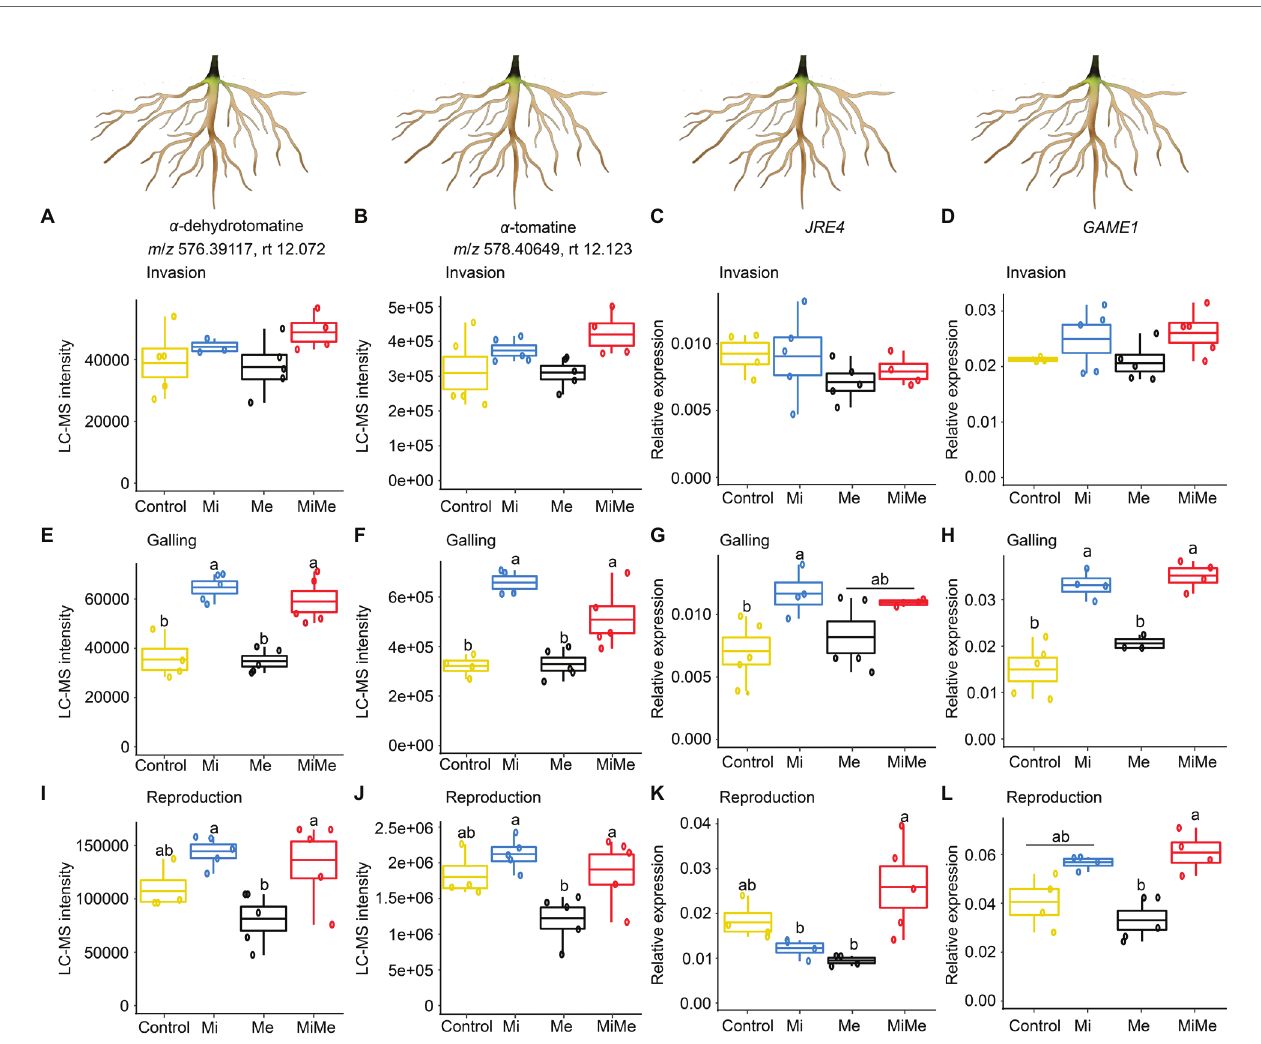
FIGURE 6 | Relative intensities of the m/z signals of the steroidal glycoalkaloids α -dehydrotomatine and α -tomatine and relative expression of glycoalkaloid-related metabolism genes jasmonate-responsive ethylene response factor (ERF) 4 transcription factor (JRE4) and glycoalkaloid metabolism 1 (GAME1) in tomato roots upon aboveground and belowground herbivory. Mean LC-MS intensities of α -dehydrotomatine ( m/z 576.39117; rt. 12.072 min) and α -tomatine ( m/z 578.40649; rt. 12.123 min) and expression of JRE4 and GAME1 in roots of tomato plants infected belowground with Meloidogyne incognita (Mi), infested aboveground with Macrosiphum euphorbiae (Me), or with both herbivores (MiMe). Control = plants without herbivores. Boxplots indicate the mean (±SEM, n = 5) of α -dehydrotomatine (A,E,I) , α -tomatine (B,F,J) m/z intensities, JRE4 (C,G,K) , and GAME1 (D,H,L) measured at the nematodes’ invasion (A-D) , galling (E-H) , or reproduction (I-L) stages. Different letters above the boxplots indicate significant differences ( p ≤ 0.05) in mean values between treatments, determined by Tukey's HSD test after ANOVA